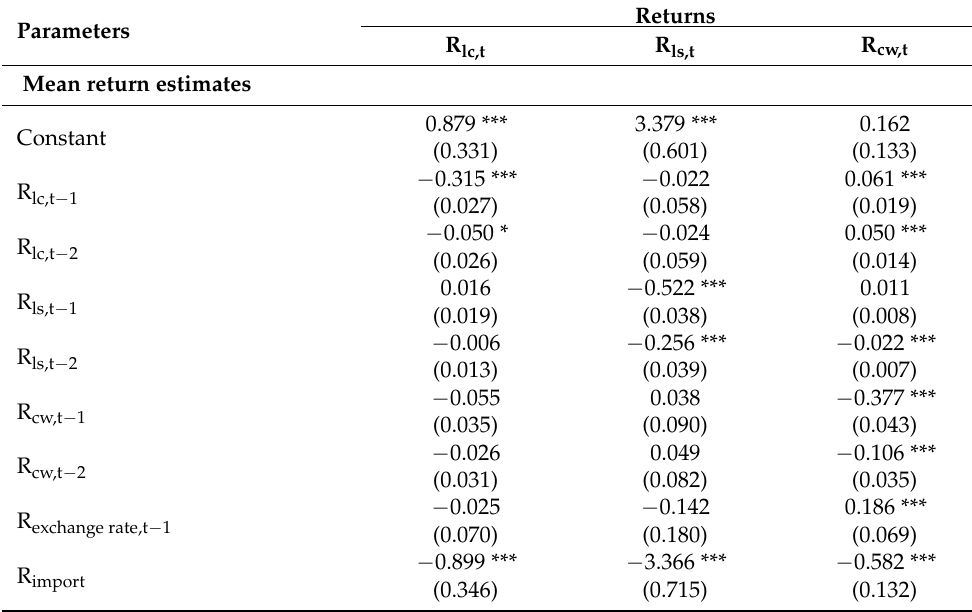
Table 2. Parameter estimates for both mean returns and conditional